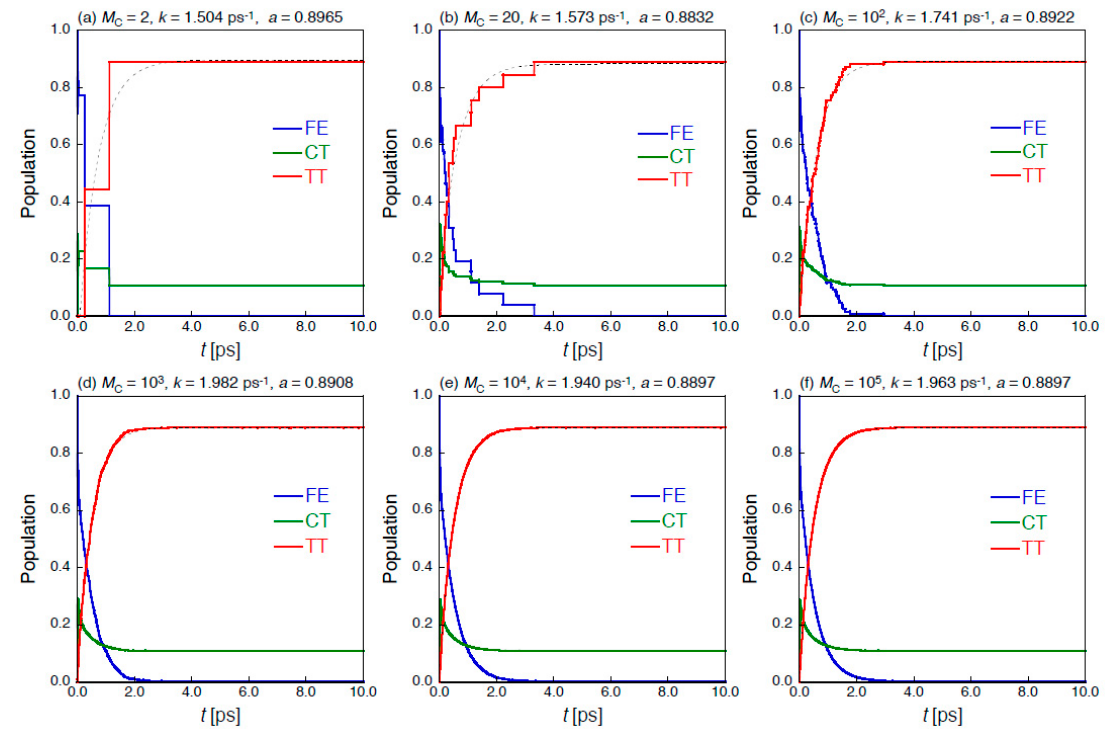
Figure 3. Ensemble results of MCWF time-evolution of diabatic exciton state {FE, CT, TT} populations